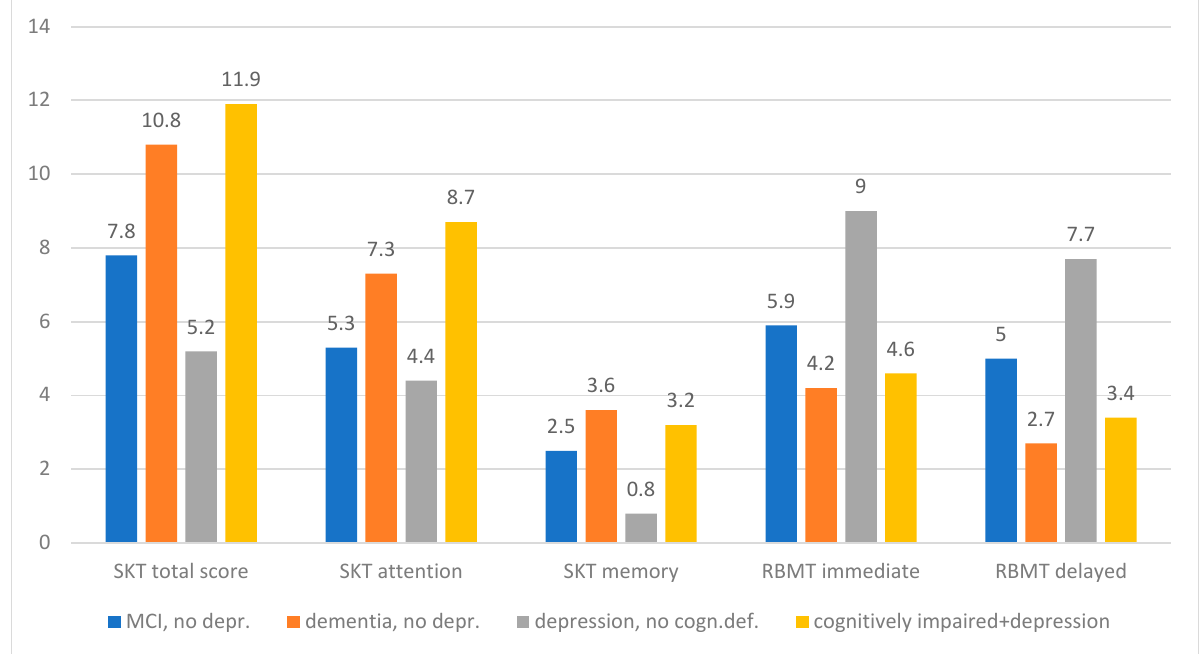
Figure 1. SKT and RBMT: diagnosis groups.